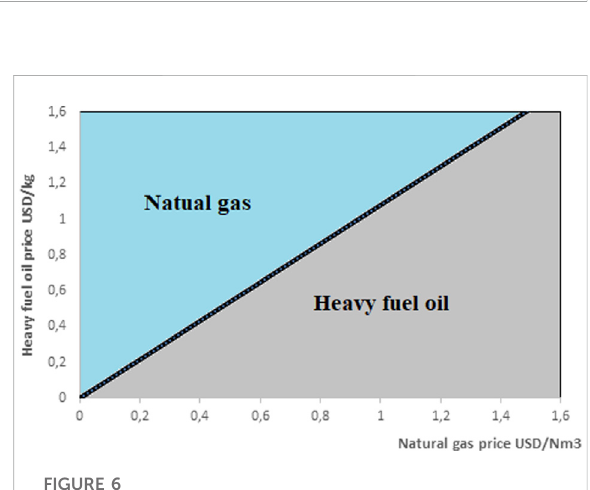
FIGURE 6 The price break-even line of producing an amount of steam at the same cost, using heavy fuel oil or natural